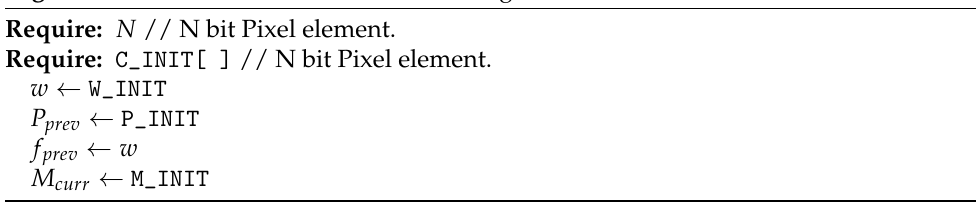
Algorithm 4 Initialization for variable bit-length ADPCM.